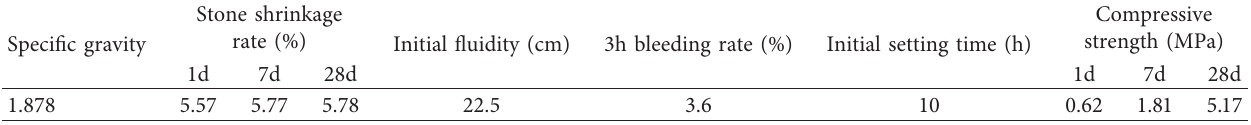
Table 7: Grouting material properties with the optimal